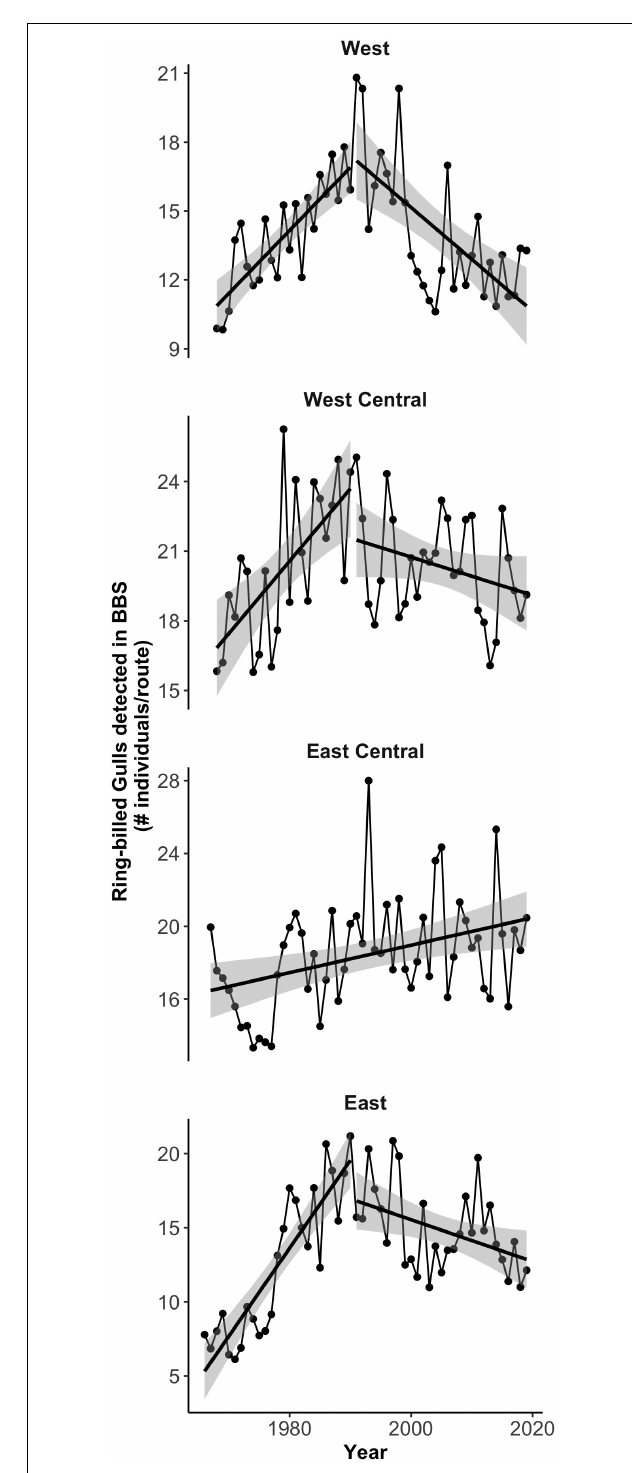
FIGURE 6 | Ring-billed Gull breeding size in time for four subpopulations of North America (1960–2017). Population size increased in the West (top), West Central (top center), and East (bottom) regions prior to 1990 and decreased after 1990. In the East Central region, the population size increased throughout the whole study period (bottom center). Note that the y axes have different scales and do not start at zero.